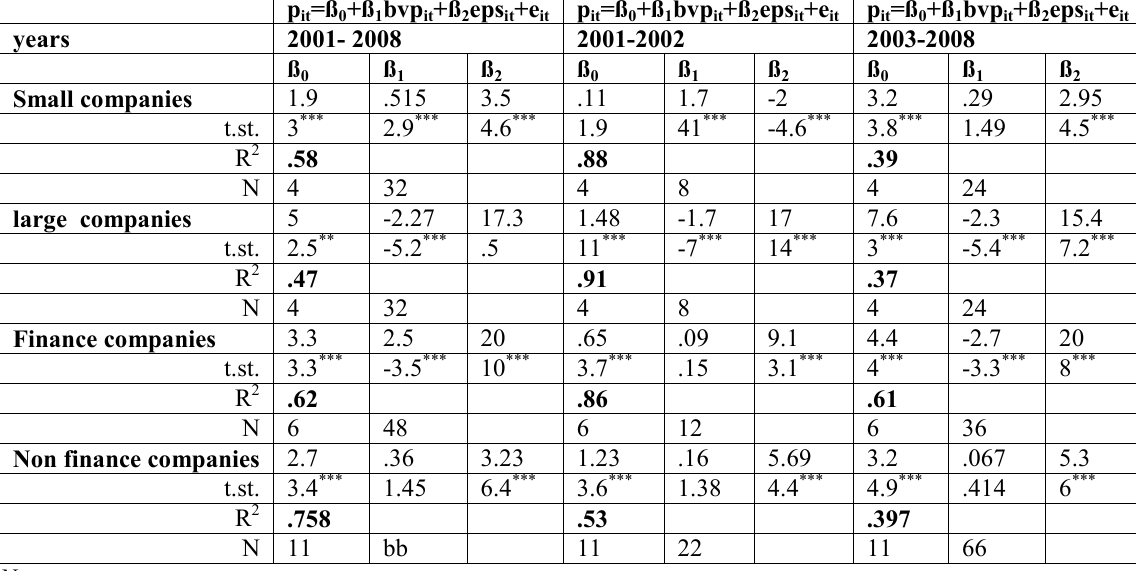
Table 4 Result of Regression Approach based on firm size and